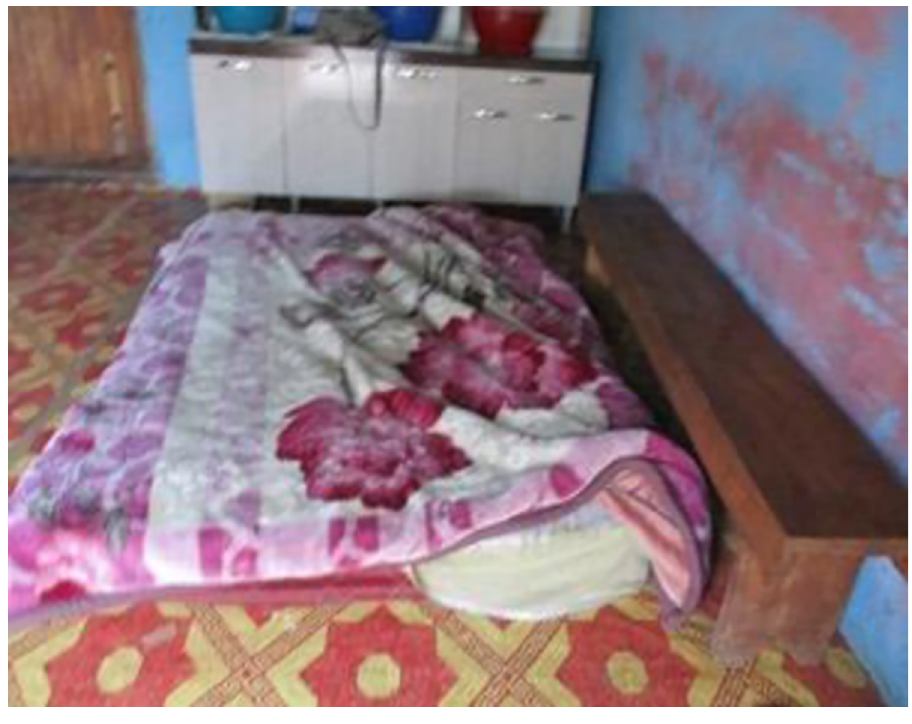
Fig 9. Image from co researcher